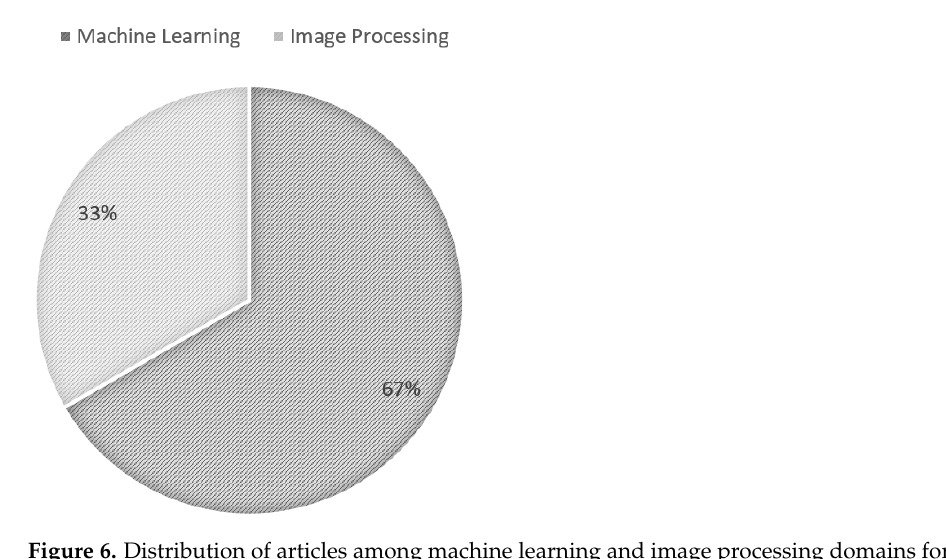
Table 1. Image Processing Methods for Crack Detection.